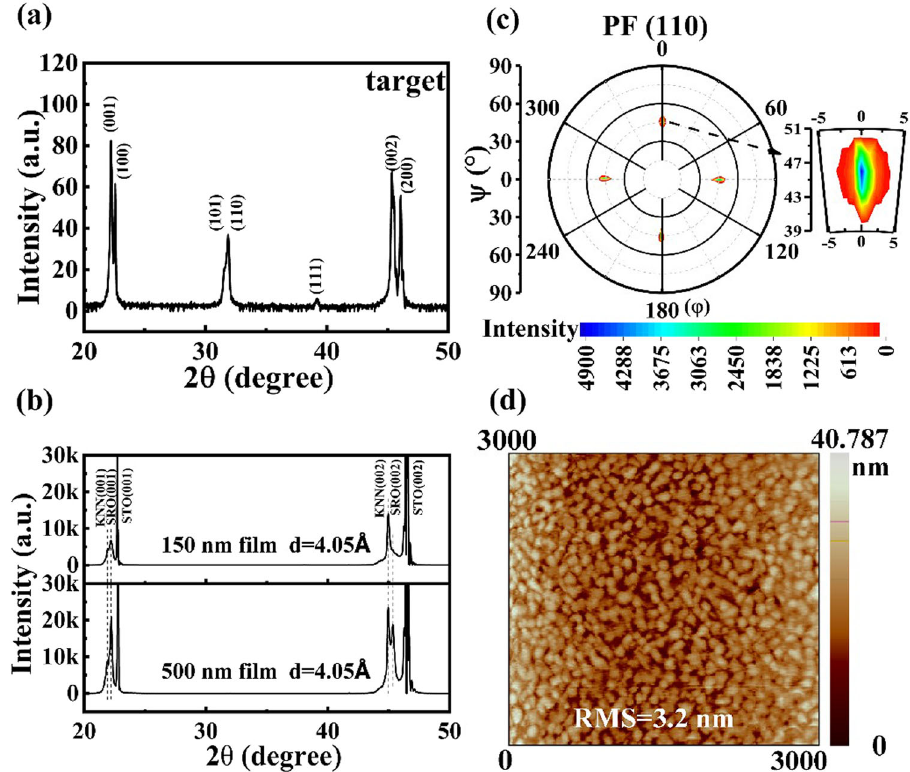
Fig. 3 Microstructure and morphology of KNN target and fi lms. X-ray diffraction 2 θ scan patterns of ( a ) the KNN ceramic target and ( b ) 150 nm- and 500 nm-thick KNN fi lms; c the (110) XRD pole fi gure of the 500 nm KNN fi lm; d an AFM surface scan image of the 150 nm KNN fi